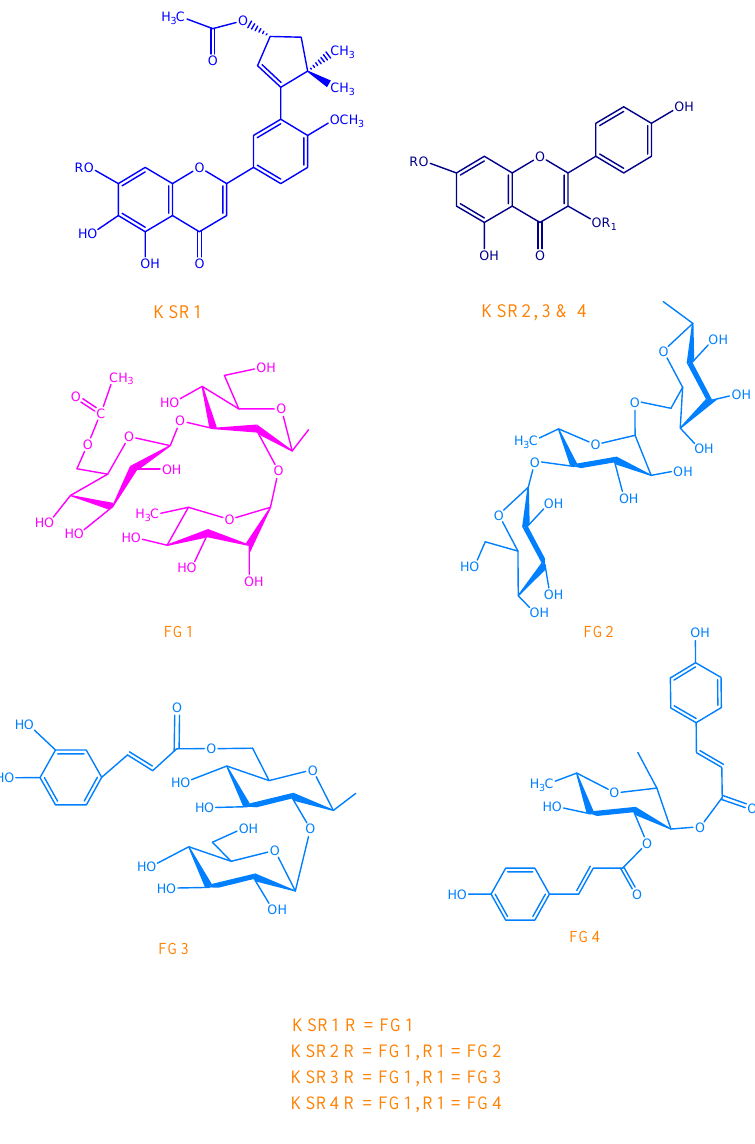
Figure 1 . Structures of isolated compounds KSR1 -